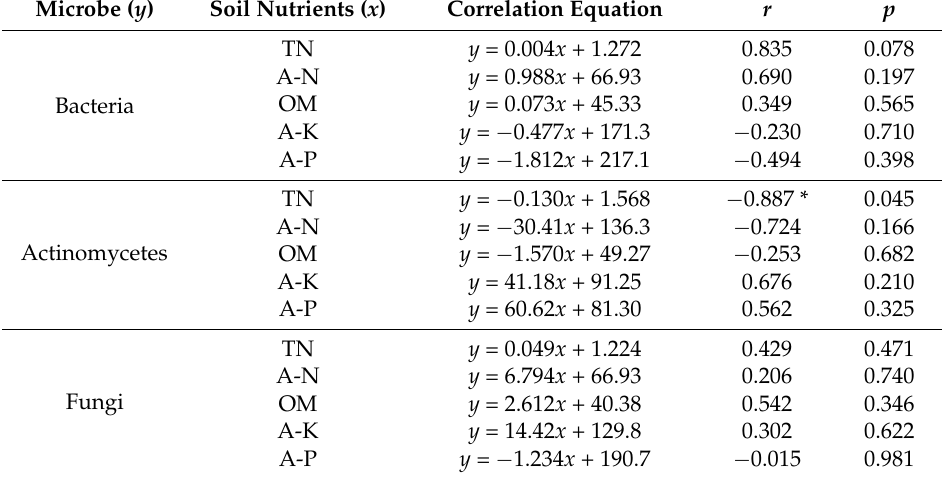
Table 1. Correlation analysis of bacteria, actinomycetes, and fungi between major soil nutrients. Microbe ( y ) Soil Nutrients ( x ) Correlation